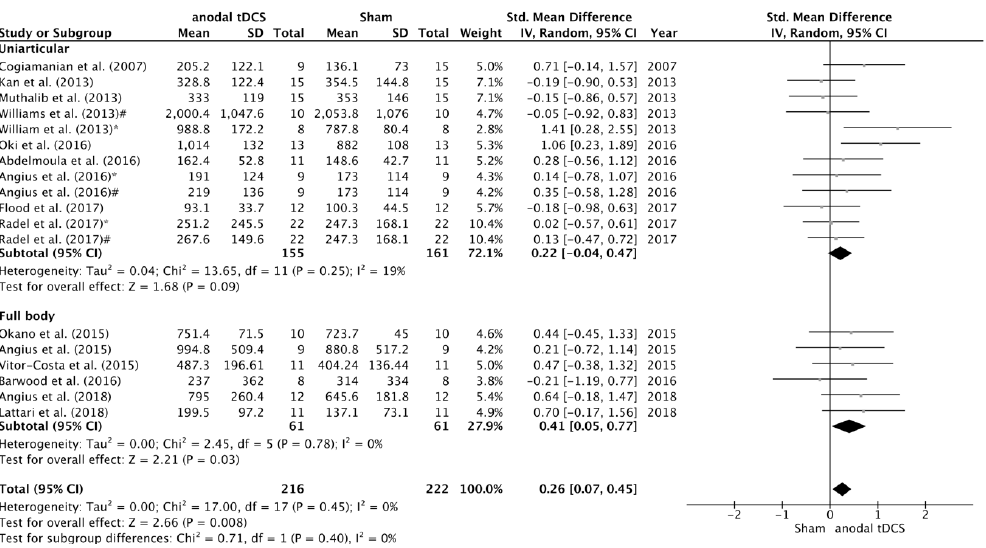
Figure 6. Forest plot of the subgroup analysis for the comparison of the effects of anodal tDCS on TTF between studies that used whole-body (i.e., cycling) versus uniarticular (i.e., submaximal isometric contractions until failure) tasks. Williams et al. (2013) *—subgroup that received full time anodal tDCS during the task (i.e., submaximal isometric elbow contraction until failure). Williams et al. (2013) #—subgroup that received part time anodal tDCS during the task (i.e., submaximal